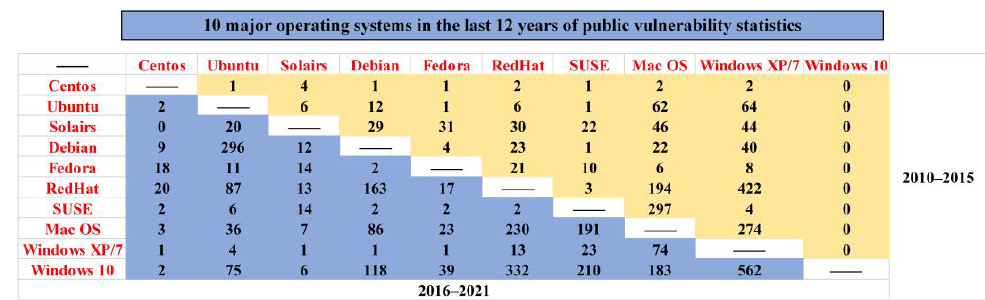
Figure 7. Common vulnerability statistics.